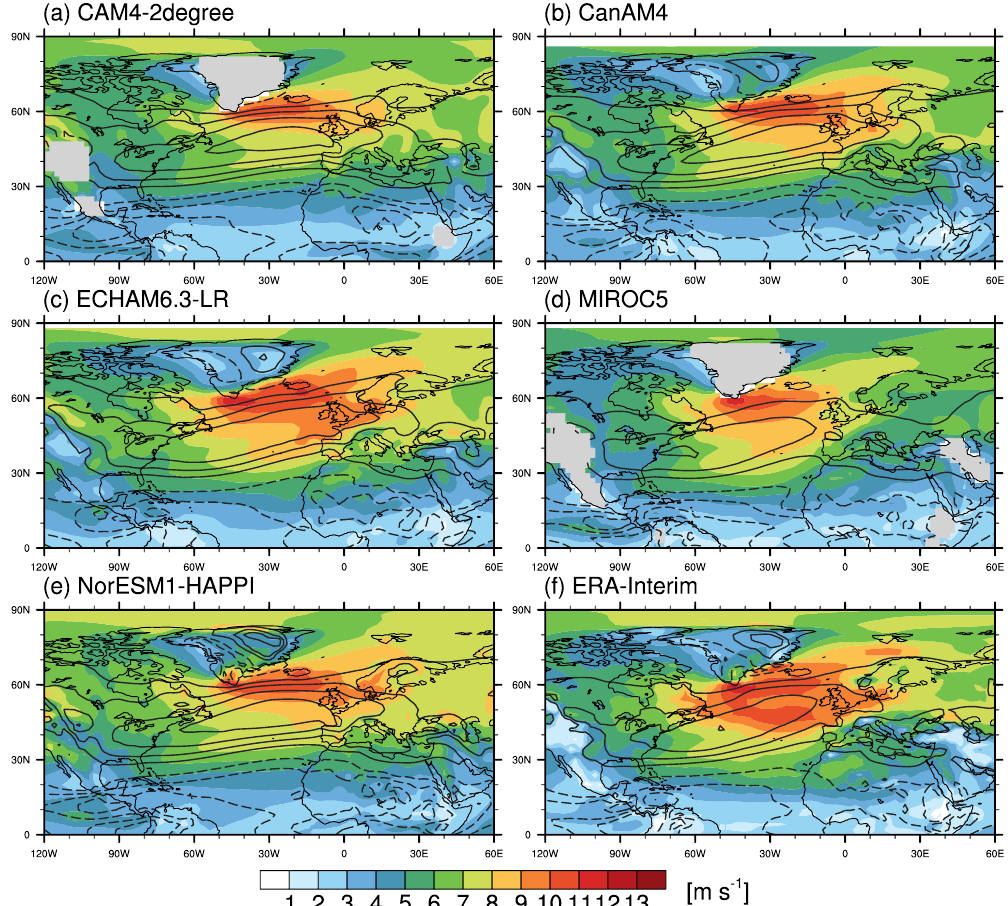
Figure 3. Ensemble means of the DJF mean daily standard deviation of the 850hPa zonal wind (shading, in ms − 1 ) and of the DJF 850hPa zonal wind climatology (contours, interval: 3ms − 1 , zero contour omitted, and negative values with dashed lines) for (a) CAM4-2degree, (b) CanAM4, (c) ECHAM6.3-LR, (d) MIROC5, and (e) NorESM1-HAPPI. The daily standard deviation is calculated for each member separately and then averaged over the ensemble. (f) DJF mean daily standard deviation (shading, in ms − 1 ) and climatology (contours, interval: 3ms − 1 , zero contour omitted, and negative values with dashed lines) of the 850hPa zonal wind for the period 2006–2015 of